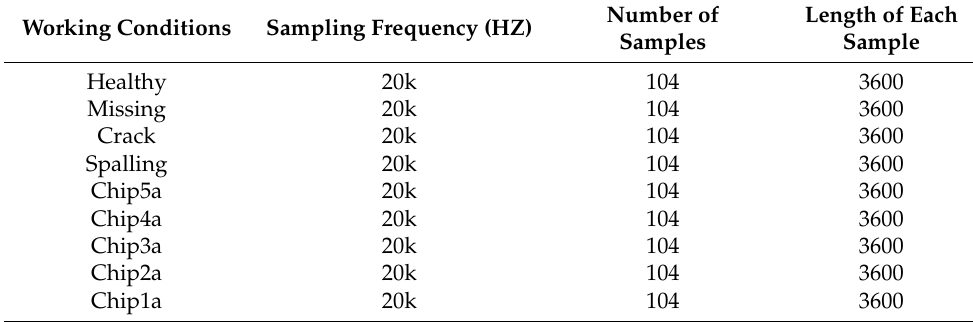
Table 1. Metadata of the gearbox dataset.